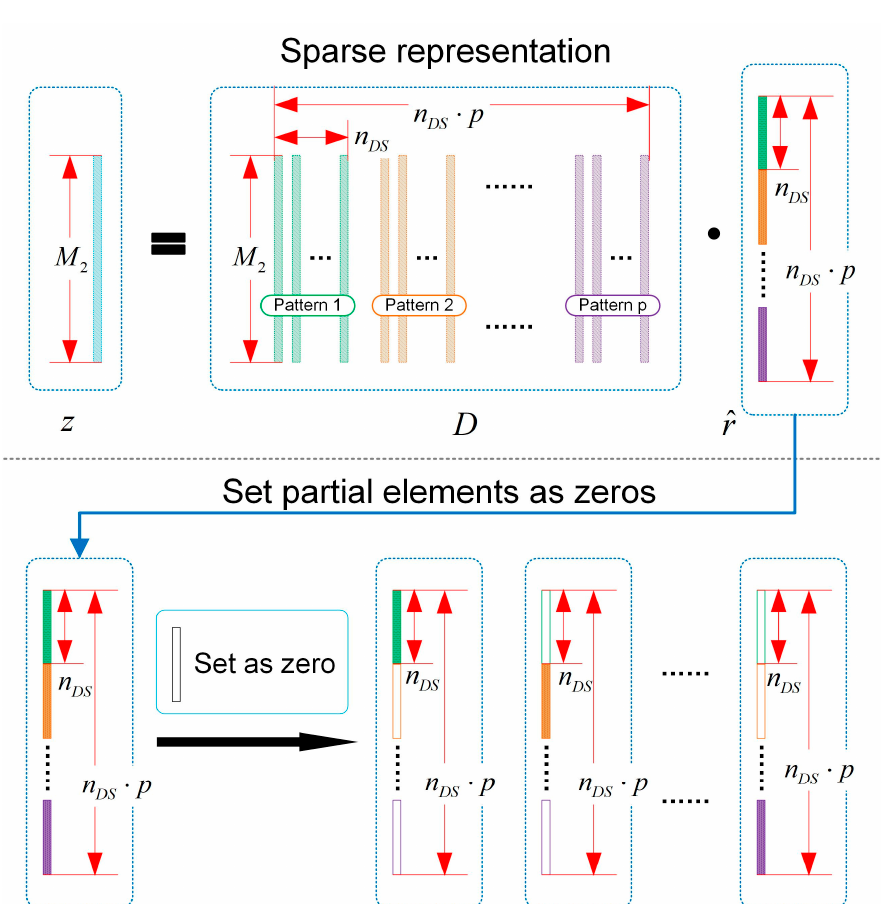
Figure 5. Sparse representation and zero setting.